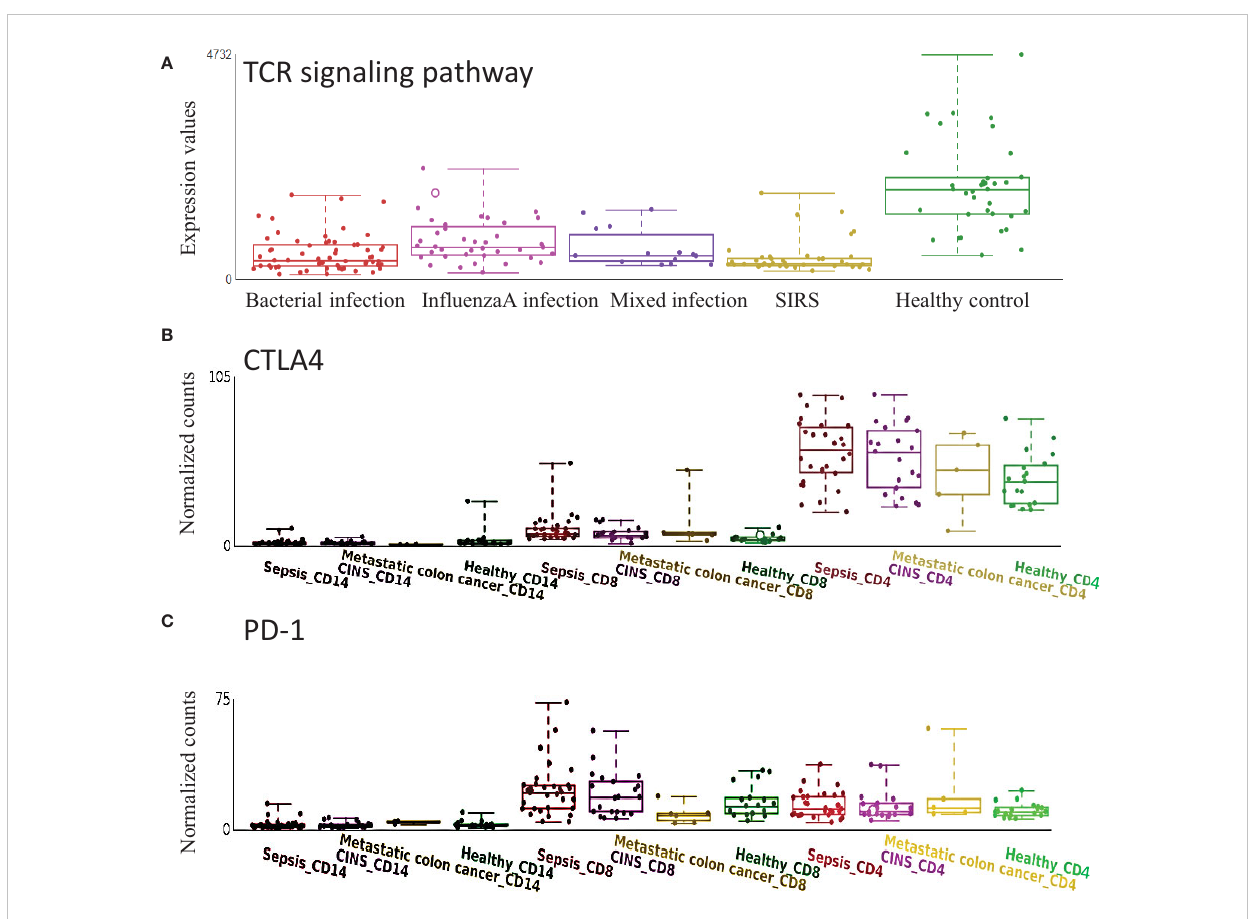
FIGURE 5 Expression of T cell receptor (TCR) signaling pathway and related genes are altered in sepsis. (A) TCR signaling pathway is down-regulated in sepsis with different etiology. (B) CTLA4 is mainly expressed on CD4 + T cells and is up-regulated in sepsis. (C) PD1 is mainly expressed on CD8 + T cells and is up-regulated in sepsis. CINS: critically ill non-infected